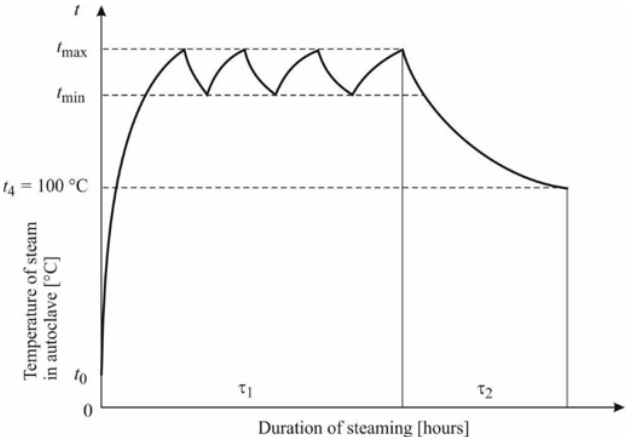
Figure 2. Mode of color modification of beech wood by steaming with a saturated mixture of steam and air or saturated water steam. Note: Reproduces from Dzurenda, L. Colouring of beech wood during thermal treatment using saturated water steams; published by Acta Fac. Xylologiae Zvolen, 2014, with permission from Acta Fac. Xylologiae Zvolen,